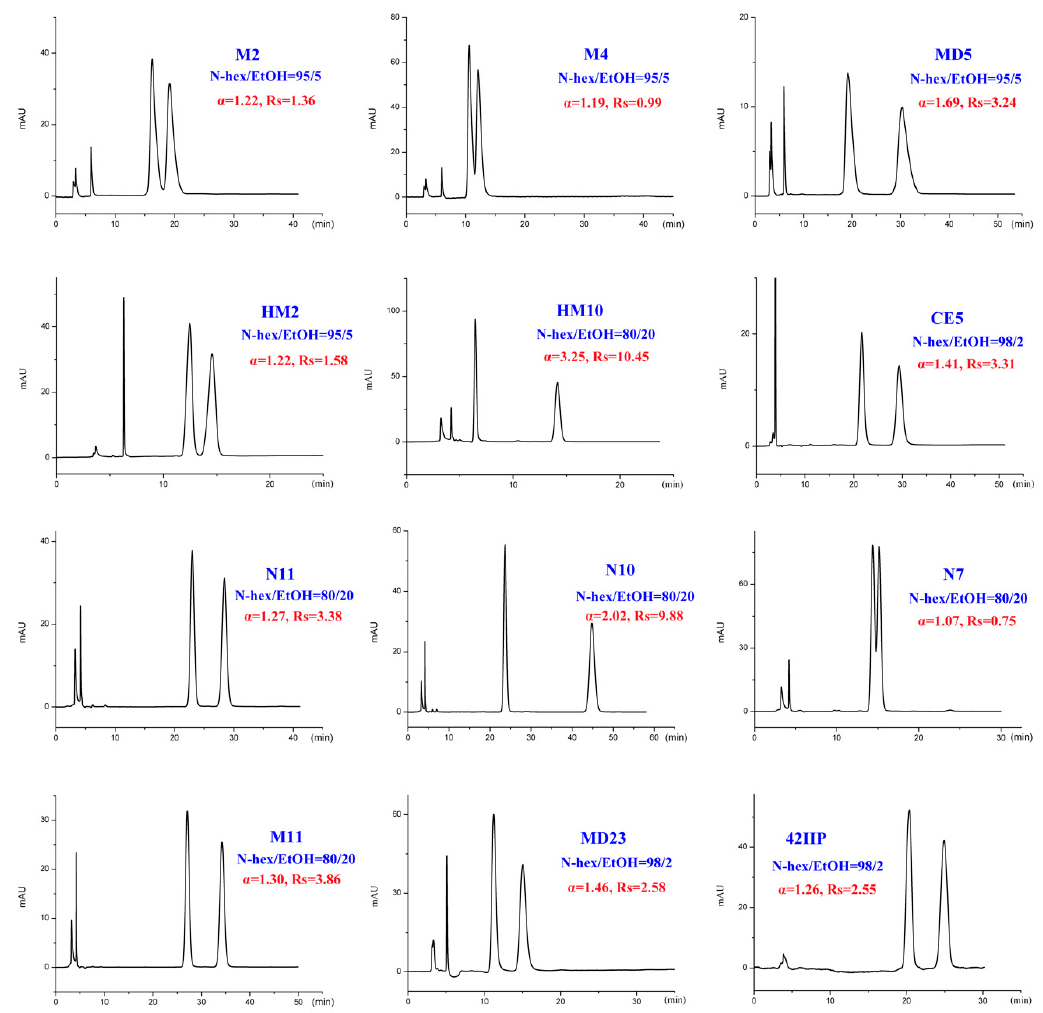
Figure 3. Typical chromatograms with ethanol (EtOH) as organic modifier under normal-phase mode.